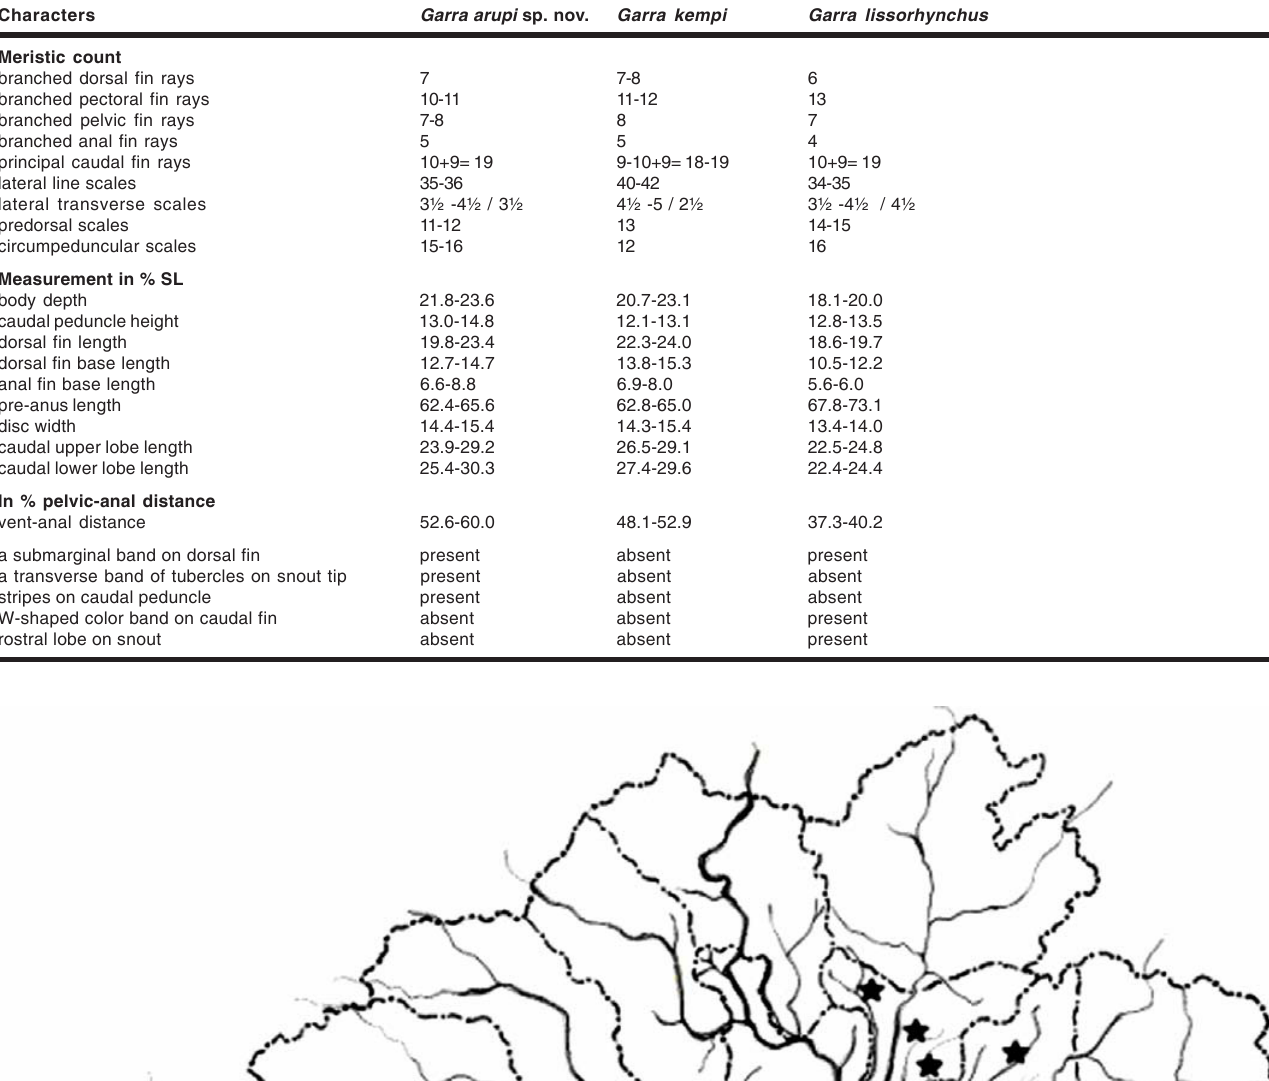
Table 2. Differentiating characteristics of Garra arupi sp. nov. from its closest